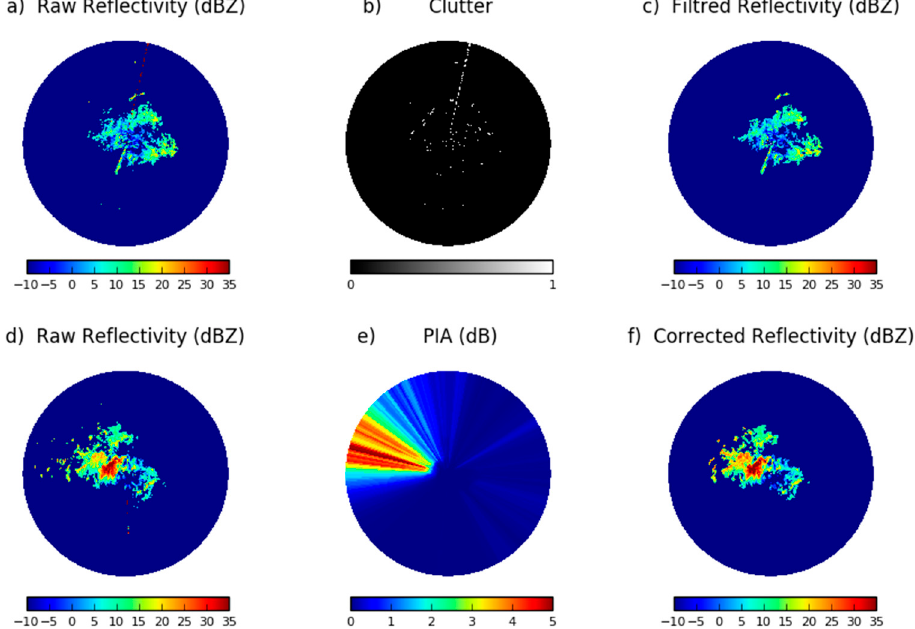
Figure 2. ( a ) Raw, ( b ) cluttered and ( c ) filtered reflectivity pertaining to December 16, 2016 at 08:30 UTC; ( d ) raw, ( e ) path-integrated attenuation (PIA) and ( f ) corrected reflectivity pertaining to December 17, 2016 at 02:20 UTC.